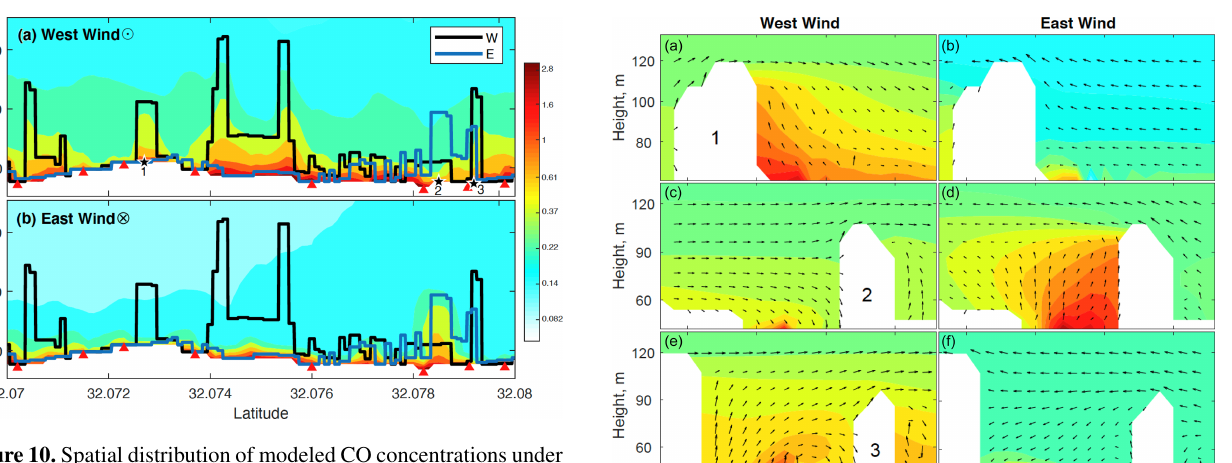
Figure 10. Spatial distribution of modeled CO concentrations under west (a) and east (b) wind directions (3ms − 1 ) in latitude–height cross sections along Zhongyang Road during rush hours (marked as a red line 2 in Fig. 3b). The outlines of buildings on both sides of the road are shown as black (west side) and blue (east side) lines. Red triangles show the locations of major road intersections. Figure 11. Spatial distribution of modeled CO concentrations and wind vectors in longitude–height cross sections along three build- ings on Zhongyang Road (marked as stars in Fig. 10a). The concen- tration distributions under west (a, c, e) and east (b, d, f) winds are shown. Note the vertical velocity is scaled by a factor of